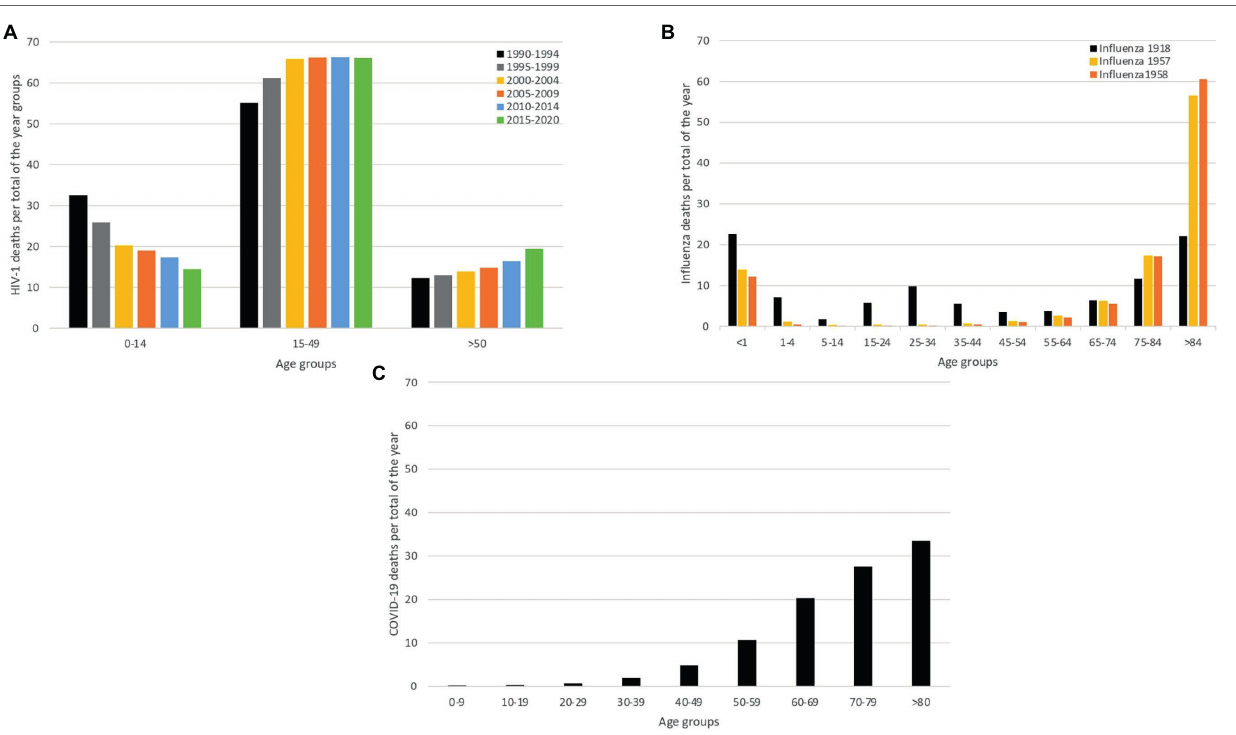
FIGURE 1 | Mortality caused by HIV-1, Influenza and COVID-19. We compare mortality between two acute infectious diseases (SARS-CoV-2 and influenza pandemic) and a chronic infectious disease (HIV), to demonstrate that their impact on mortality is inherently different. For all the infectious diseases, we show deaths proportional to age (panels A–C ). (A) Age-proportional deaths divided into six time-periods grouped by 4 years (1990–1994; 1995–1999; 2000–2004; 2005–2009; 2010–2014 and 2015–2020), to show the age-specific mortality evolution over the years (UNAIDS, 2022). (B) Influenza age-proportional deaths for three major influenza pandemics (1918, 1957 and 1958), to show age-specific mortality patterns over the different influenza pandemics (Luk et al., 2001). (C) Age-proportional COVID-19 deaths for the first year of the pandemic (2020), when only non-pharmaceutical interventions were available (Riffe et al., 2021). This panel demonstrates how COVID-19 deaths exponentially increase by